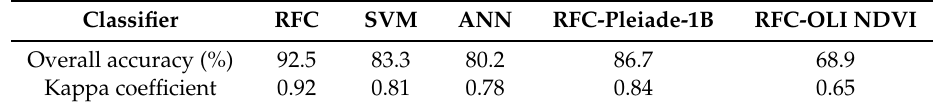
Table 2. Comparison of the overall accuracies of the three classifiers.